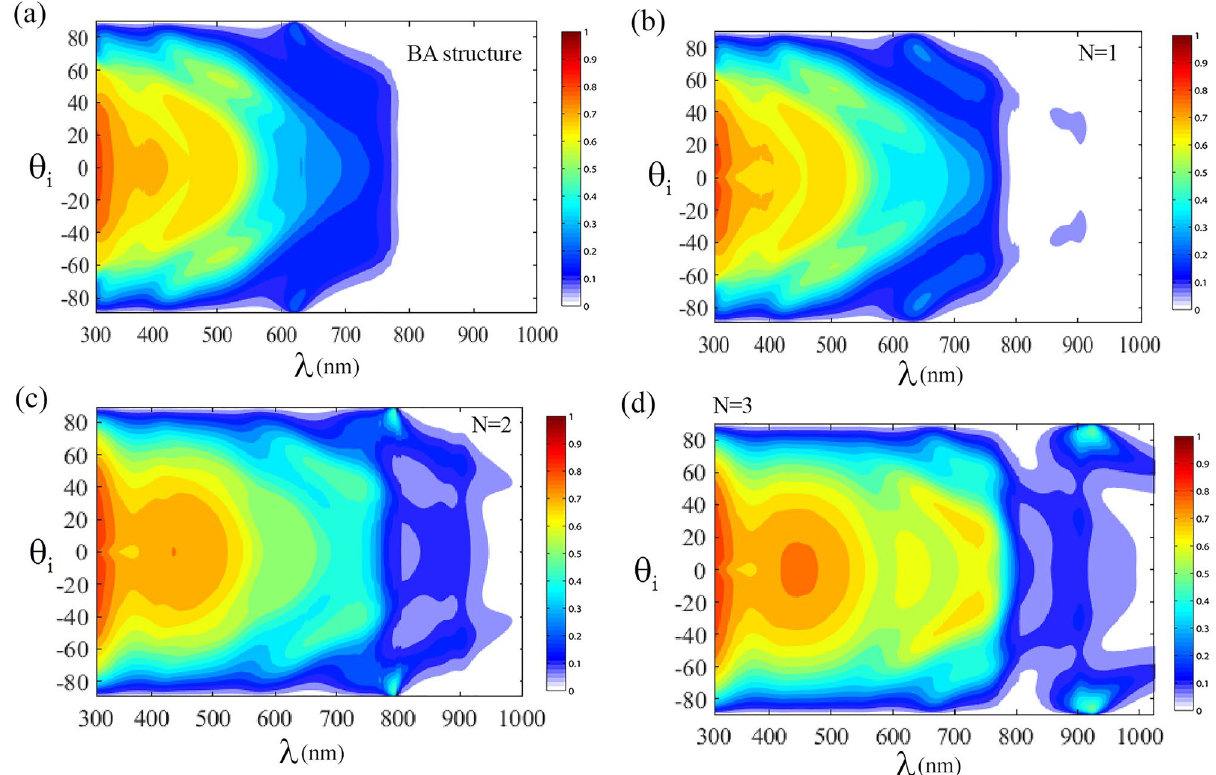
Figure 3. The absorbance coefficients as function of the wavelength of the incident light and the incident angle, ( a ) for BA structure, ( b ) N = 1, ( c ) N = 2 and ( d ) N = 3.